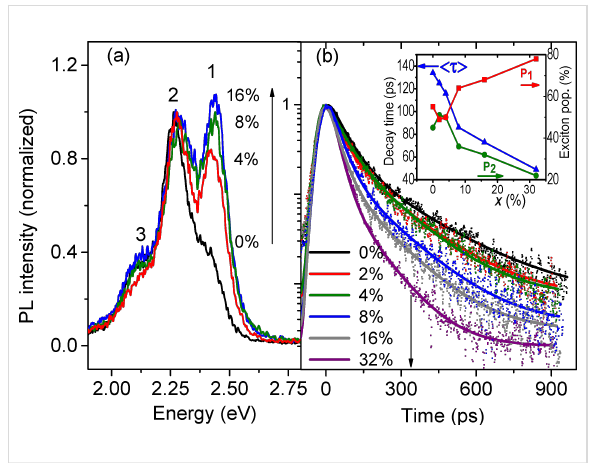
Figure 4: (a) Time-resolved PL spectra of PPV/SWNT composite films for an exciting energy E exc = 3.1 eV and for different SWNT mass percentages x . (b) Ultrafast PL dynamics at emission 2.25 eV (band 2). Solid lines are fits to the data with the bi-exponential model given by Equation 1 (see text). Inset: average lifetime and relative populations of photoexcitations in the composite films for different mass percent- ages x .